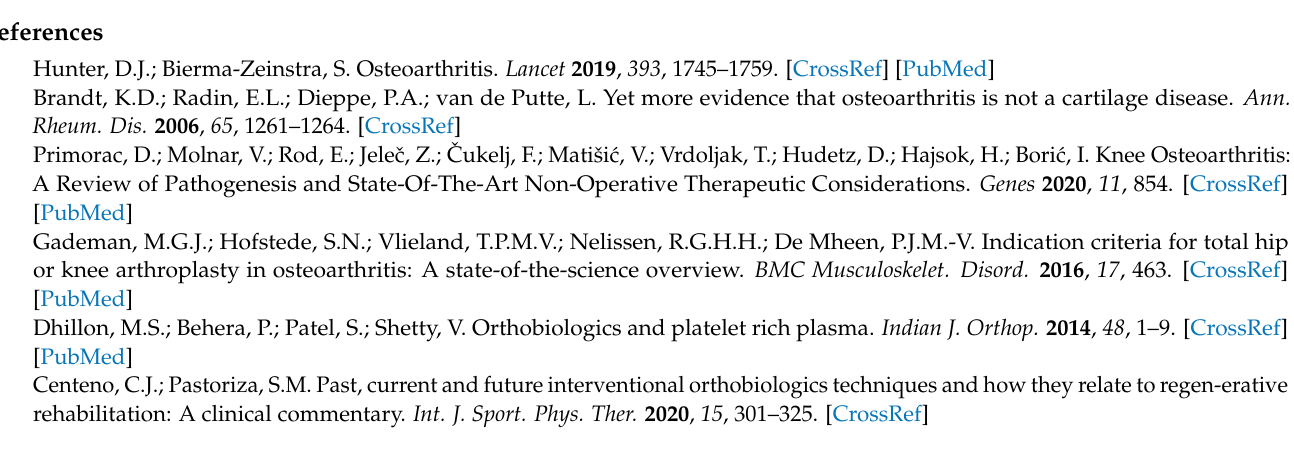
Table S6: Experimentally validated targets for first quartile EV-miRNAs; Table S7: Univocal first quartile EV-miRNA